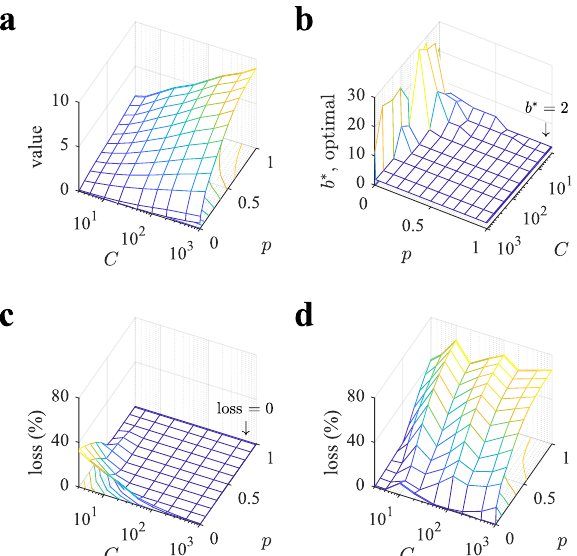
Figure 6. Depth dominates over breadth in large regions of the parameter space. ( a ) Value of playing optimally a tree as a function of capacity C and probability p . ( b ) Optimal number of sampled branches b ∗ as a function of C and p (note that C and p axes have been rotated for a better data visualization). The large plateau corresponds to the optimal number of sampled branches b ∗ = 2 . ( c,d ) Loss incurred in playing the tree always with b = 2 (c), corresponding to depth sampling, or with b = 20 (d), corresponding to breadth sampling. The large plateau in panel (c) corresponds to loss equal to zero. Losses are defined as 100 ( V opt − V )/ V opt , where V opt is the optimal value (from panel a) and V is the value of sampling the tree with the corresponding heuristic. Bellman - Monte Carlo simulation results are averaged over 3 10 6 repetitions.